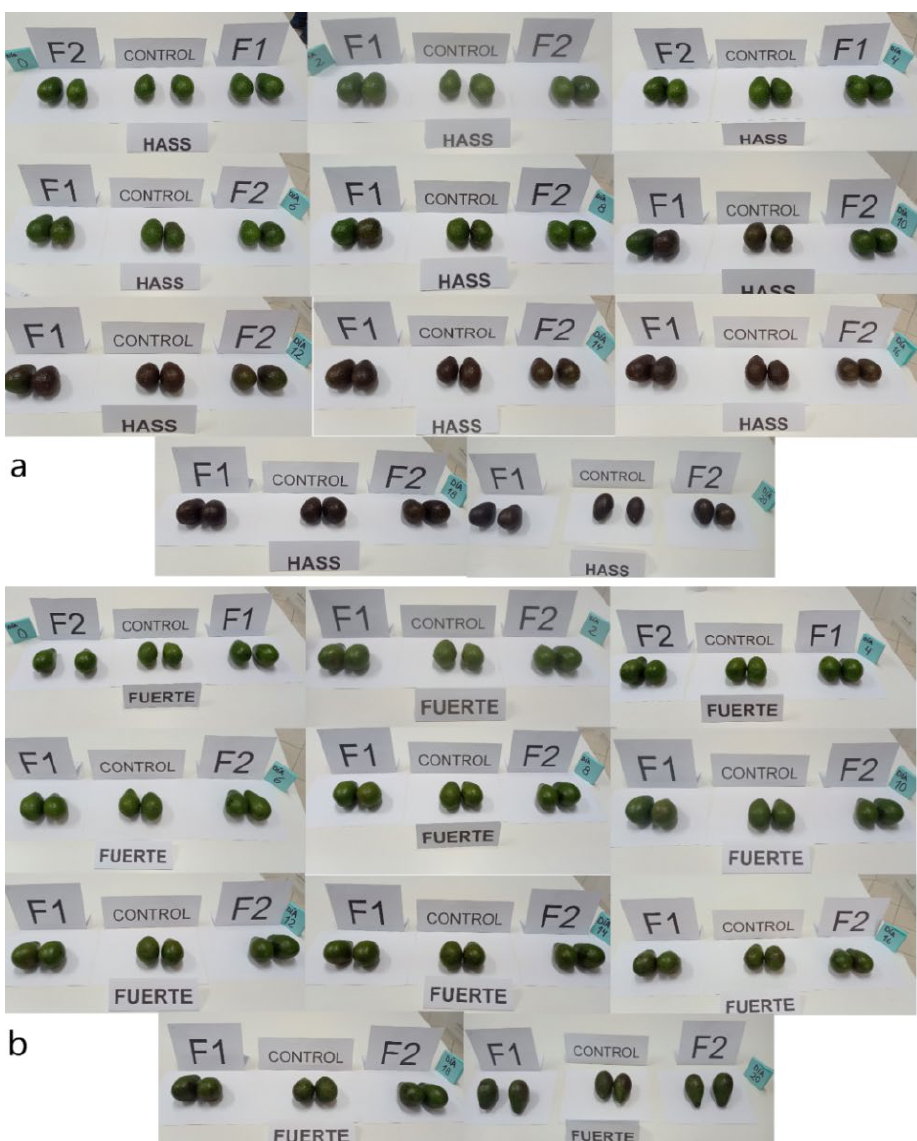
Figure 8. Color variation, ( a ) Hass variety, ( b ) Fuerte variety.